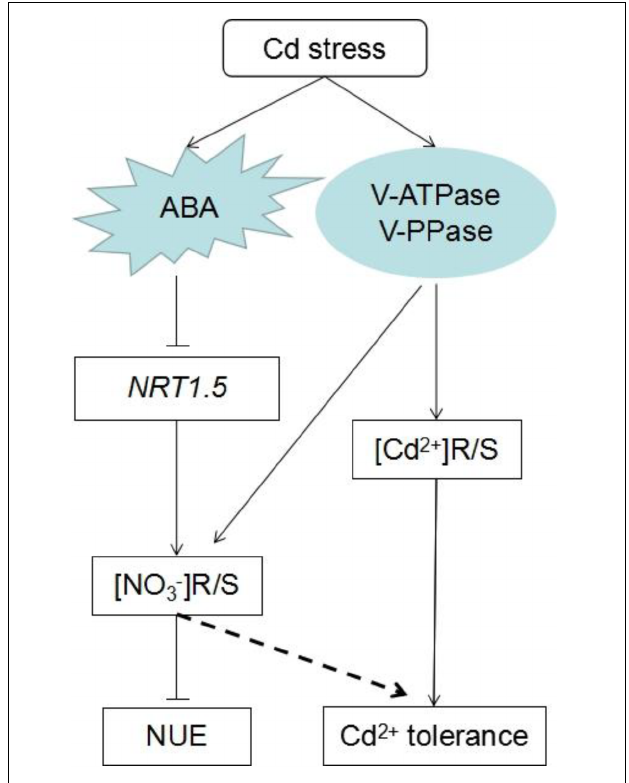
FIGURE 8 | Suggested model for ABA and proton pump enhance Arabidopsis cadmium resistance.